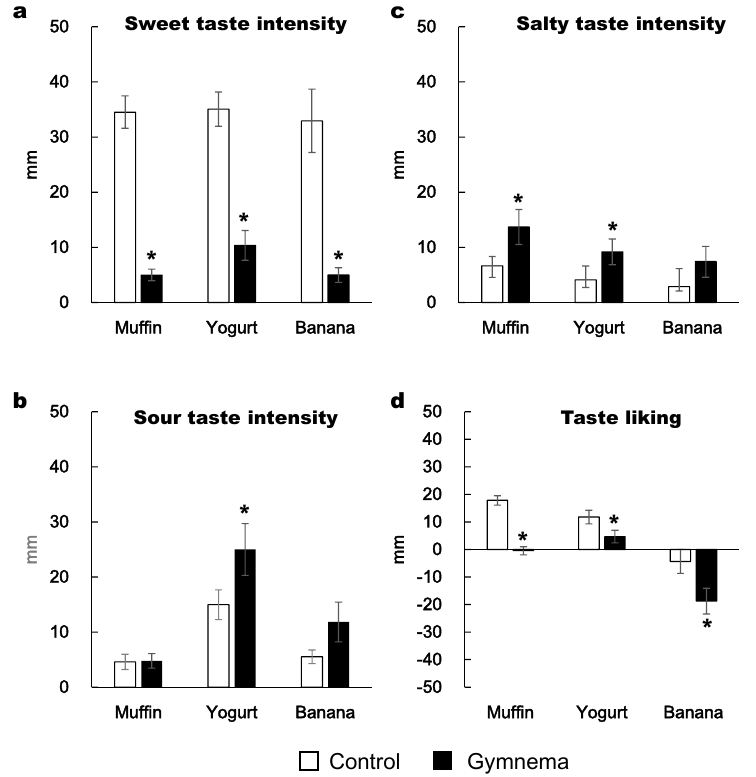
Figure 2. Subjective intensity of sweet ( a ), sour ( b ) and salty tastes ( c ), and taste liking ( d ) when consuming a muffin, yogurt and banana with Gymnema sylvestre (GS) pretreatment versus control pretreatment. Perceived taste intensity and liking were evaluated using the Labeled Magnitude Scale and Labeled Hedonic Scale, respectively. Mean ± standard error (SE). *: p < 0.05 between the two pretreatments.